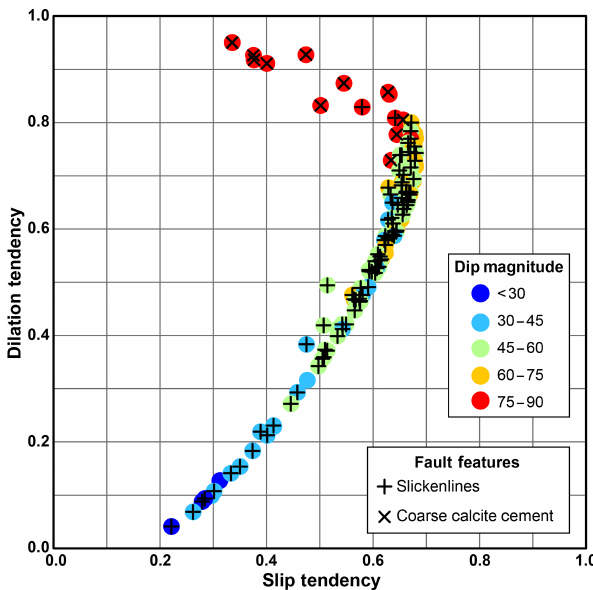
Figure 5. Comparison of dilation tendency and slip tendency for measured fault segments of the Textbook, Spanish Goat, and Big Indigo faults, color-coded by dip, with + and × symbols indicat- ing presence of slickenlines or coarse calcite cement, respectively. The few colored dots that lack additional symbols exhibit shear dis- placements, and either lack slickenlines or slickenlines could not be seen due to the planar outcrop surface in some locations. Moderate- to-high slip tendency and high dilation tendency of the steep seg- ments (dips > 75 ◦ , red points) are consistent with hybrid failure; moderate-to-high slip tendency and moderate dilation tendency of intermediate dips (45–75 ◦ , yellow and green points) are consistent with shear failure; and the low-to-moderate slip tendency and low dilation tendency of the most gently dipping segments (dips < 45 ◦ , light blue and dark blue points) are suggestive of compactive shear. See Fig. 1 for comparison.